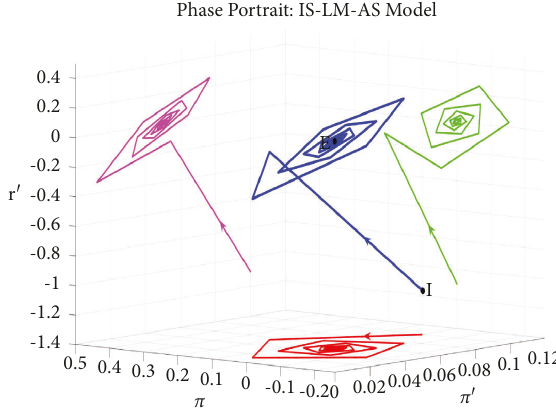
Figure 11: Projections at the R 2 three-dimensional phase portrait.